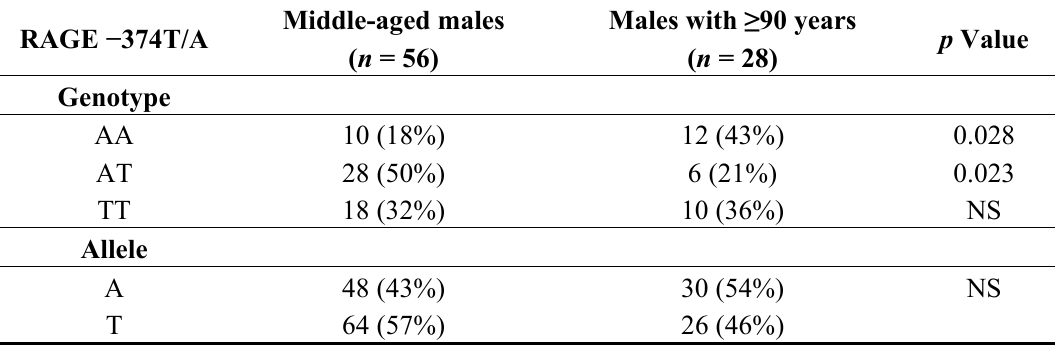
Table 3. Allelic and genotypic distribution of − 374 T/A polymorphisms in middle-aged males and long-living